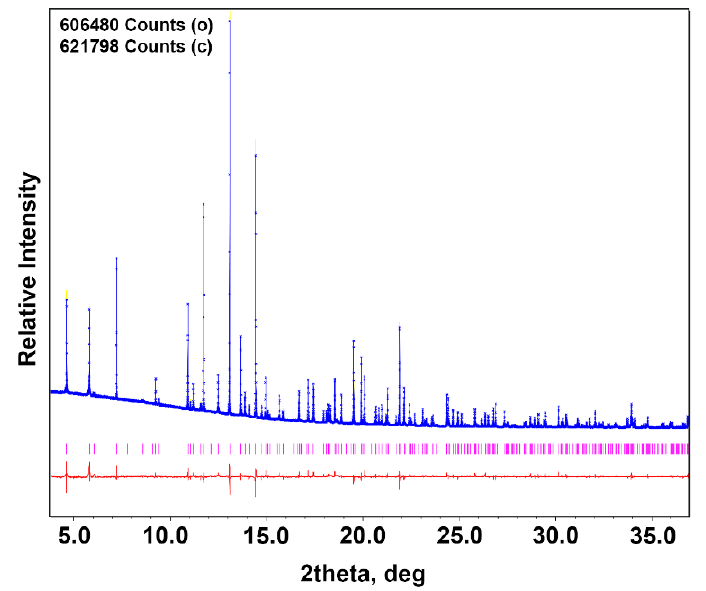
Figure 5. Observed (blue crosses), calculated (blue line) and difference (red line from below) syn- chrotron PXRD patterns for Ca 8 MnEu(PO 4 ) 7 . Magenta bars denote the peak positions of possible Bragg reflections. Table 2. Crystallographic data for Ca 8 MnEu(PO 4 ) 7 (SG R 3 c , Z = 6, T = 293 K). Sample